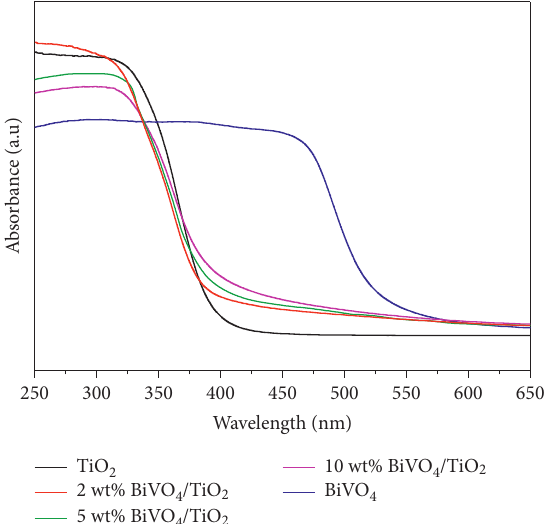
Figure 9: UV-vis absorption spectra of samples.